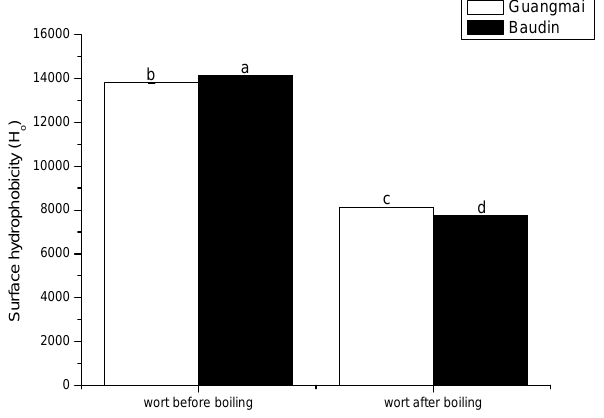
Figure 2 . Surface hydrophobicity (H ) of wort proteins (before and after boiling) with the 0 two varieties in 10 mmol/L phosphate buffer (pH 7.0). Different characters (a-d) on the top of columns represent significant difference at p<0.05 level during the